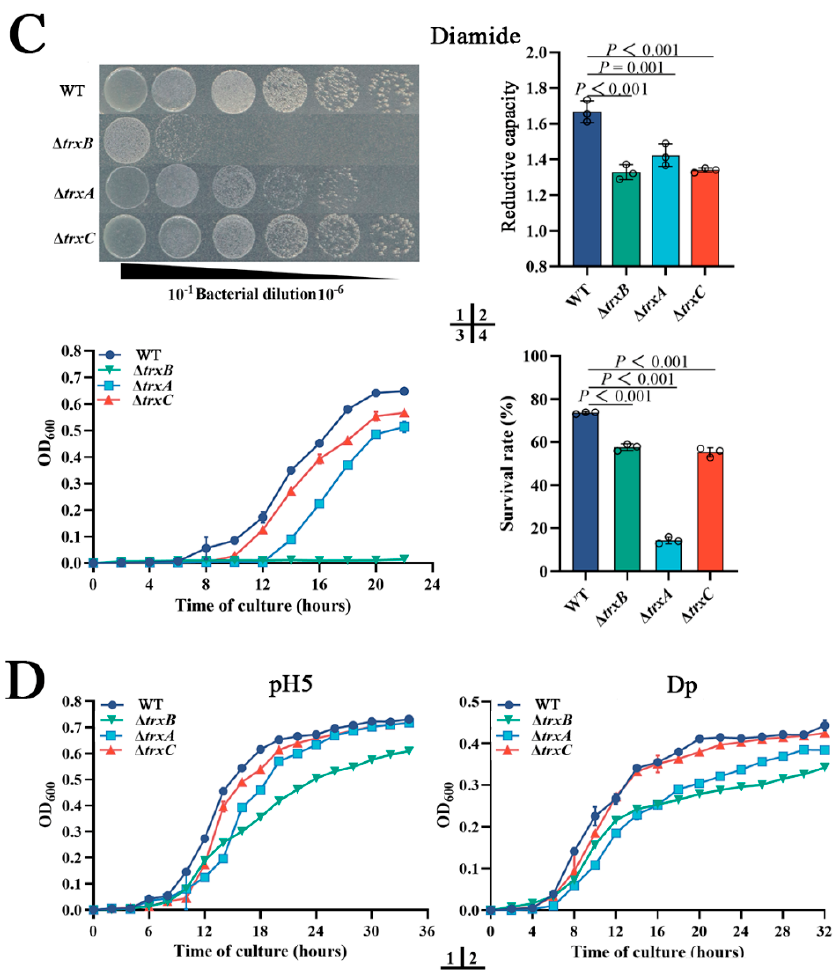
Figure 3. The roles of the Trx system in bacterial adversity resistance. ( A ) WT, Δ trxB , Δ trxA , and Δ trxC were cultured in LB broth, and then the cell density was measured at OD 600, and the intracellular reductive capacity was detected. ( B ) Bacterial growths on LB agar plates (1) and in liquid LB (3) with 300 μ M H 2 O 2 ; bacteria in the logarithmic growth phase were challenged with 30 mM H 2 O 2 for 5 h, and the intracellular reductive capacity was determined (2). Bacteria in the logarithmic growth phase were diluted to 1:1000 and treated with PBS containing 300 mM H 2 O 2 for 1 h, then the amount of viable bacteria was determined (4). ( C ) bacterial growths on LB agar plates (1) and in liquid LB (3) with 550 mM diamide; bacteria in the logarithmic growth phase were challenged with 50 mM diamide for 5 h, and intracellular reductive capacity was detected (2). Bacteria in the logarithmic growth phase were diluted to 1:1000 and treated with PBS containing 550 mM diamide for 1 h, then the content of viable bacteria was determined (4). ( D ) Strains were cultured in LB broth containing acid pressure (pH = 5) (1) or iron deficiency stress (100 µ M Dp) (2) and incubated at 28 ◦ C for 48 h. Data are expressed as means ± SEM (N = 3). N, the number of experiments performed. p values